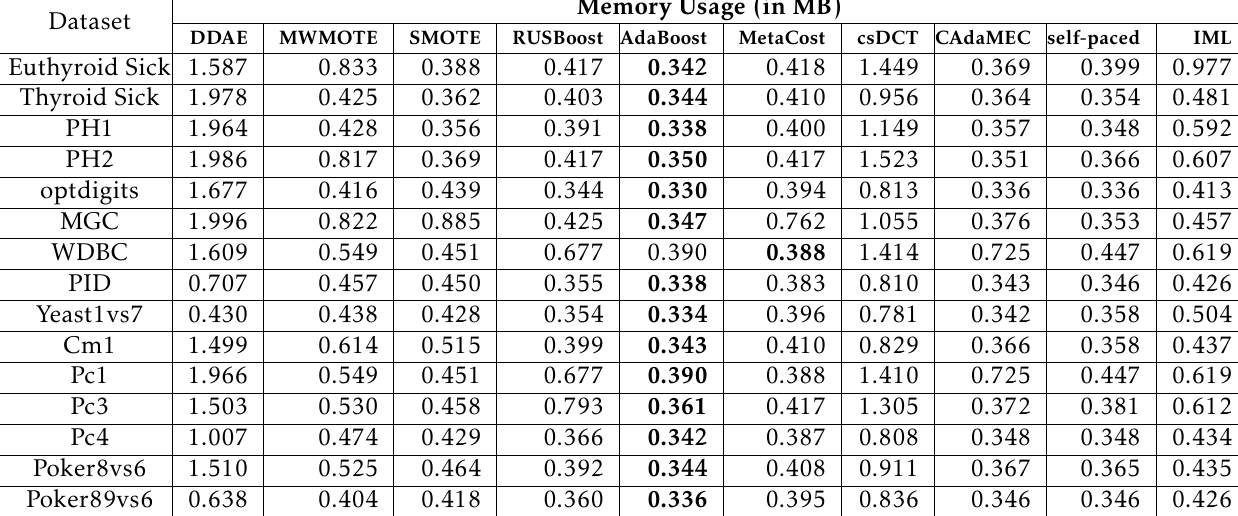
Table 24. Memory Usage for All Models on the Public